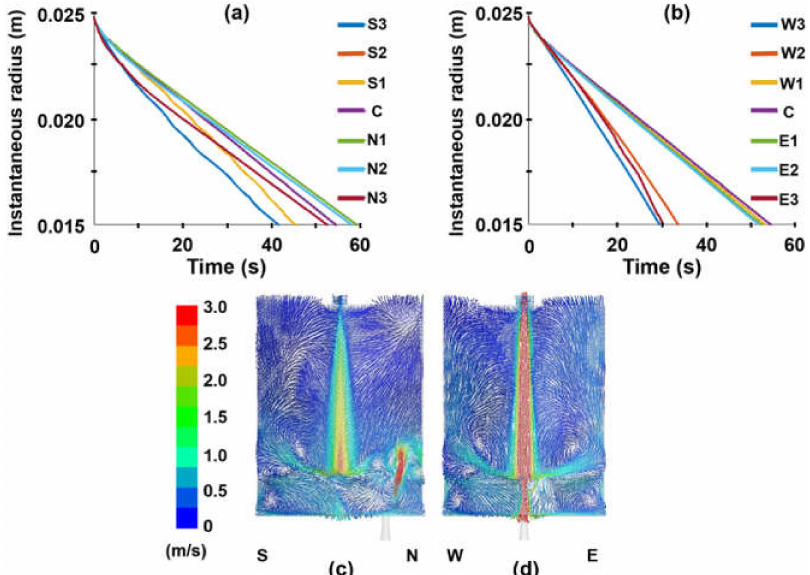
Figure 7. Melting rate of the outer shell and velocity fields in vertical planes at a bath level of 16 tons. ( a ) Axis N–S , ( b ) Axis E–W . Steel superheat is 15 K. ( c ) Central plane through the argon plume, ( d ) central plane perpendicular to the plane passing through the argon plume. The color bar is a velocity